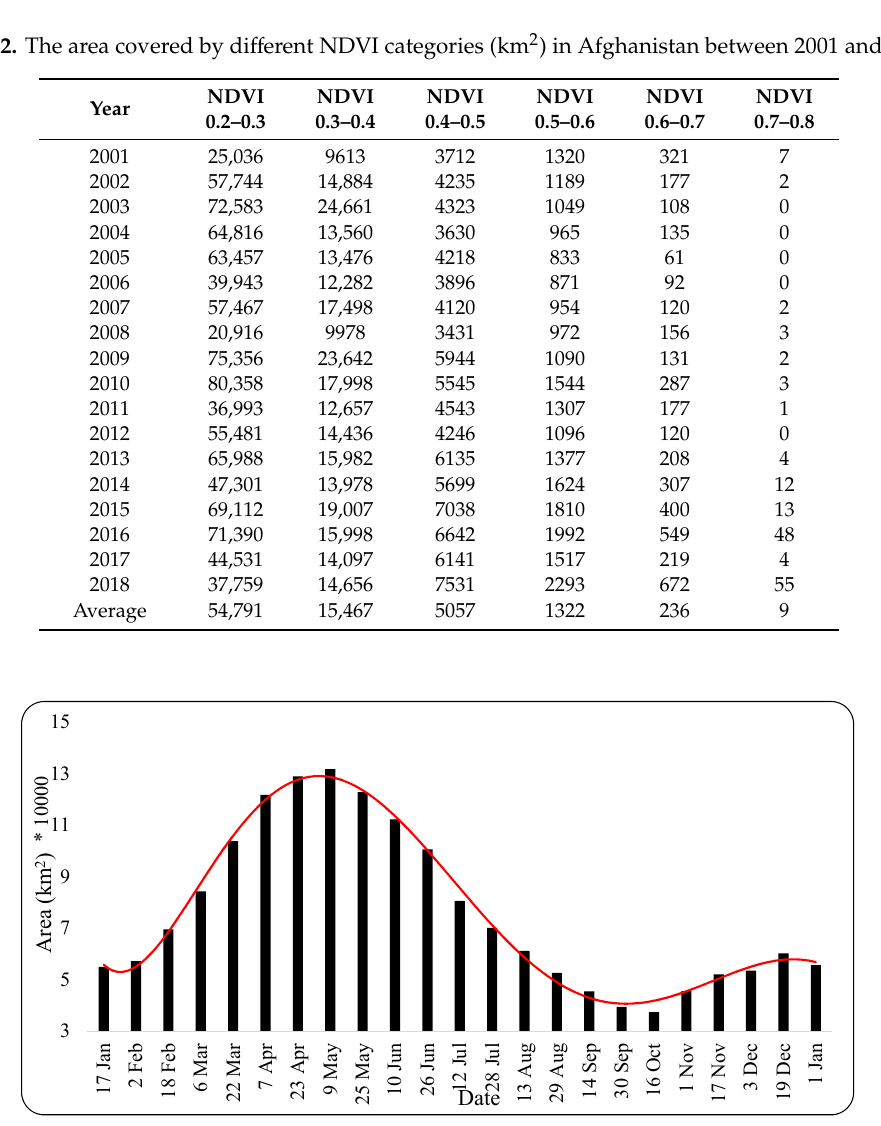
Figure 3. The average vegetation coverage in Afghanistan between 2001 and 2018.